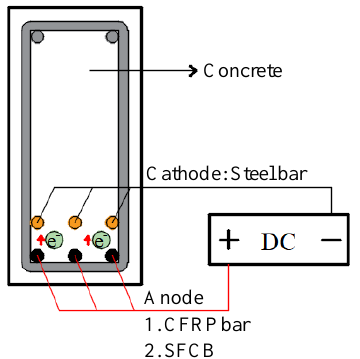
Figure 1. The cross-section of the hybrid-reinforced concrete beam with the new impressed current cathodic protection ( ICCP) system.